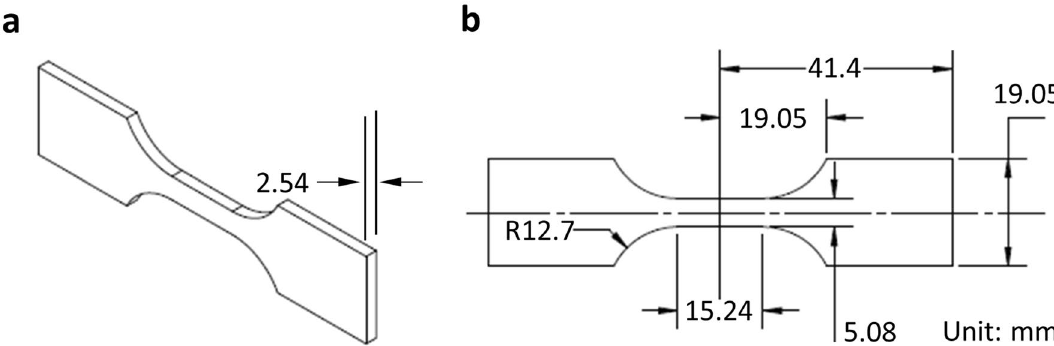
Figure 5. (a) The geometry of the fatigue bar. The unit is mm. The specimen profile was cut by wire electrical discharge machining (EDM) followed by longitudinal polishing of the edges to a surface finish of R a = 0.4 µm. Machined (M) specimens had faces machined by low-stress grinding followed by longitudinal polishing to a surface finish of R a = 0.4 µm. (b) Dimensioned drawing of the fatigue bar.